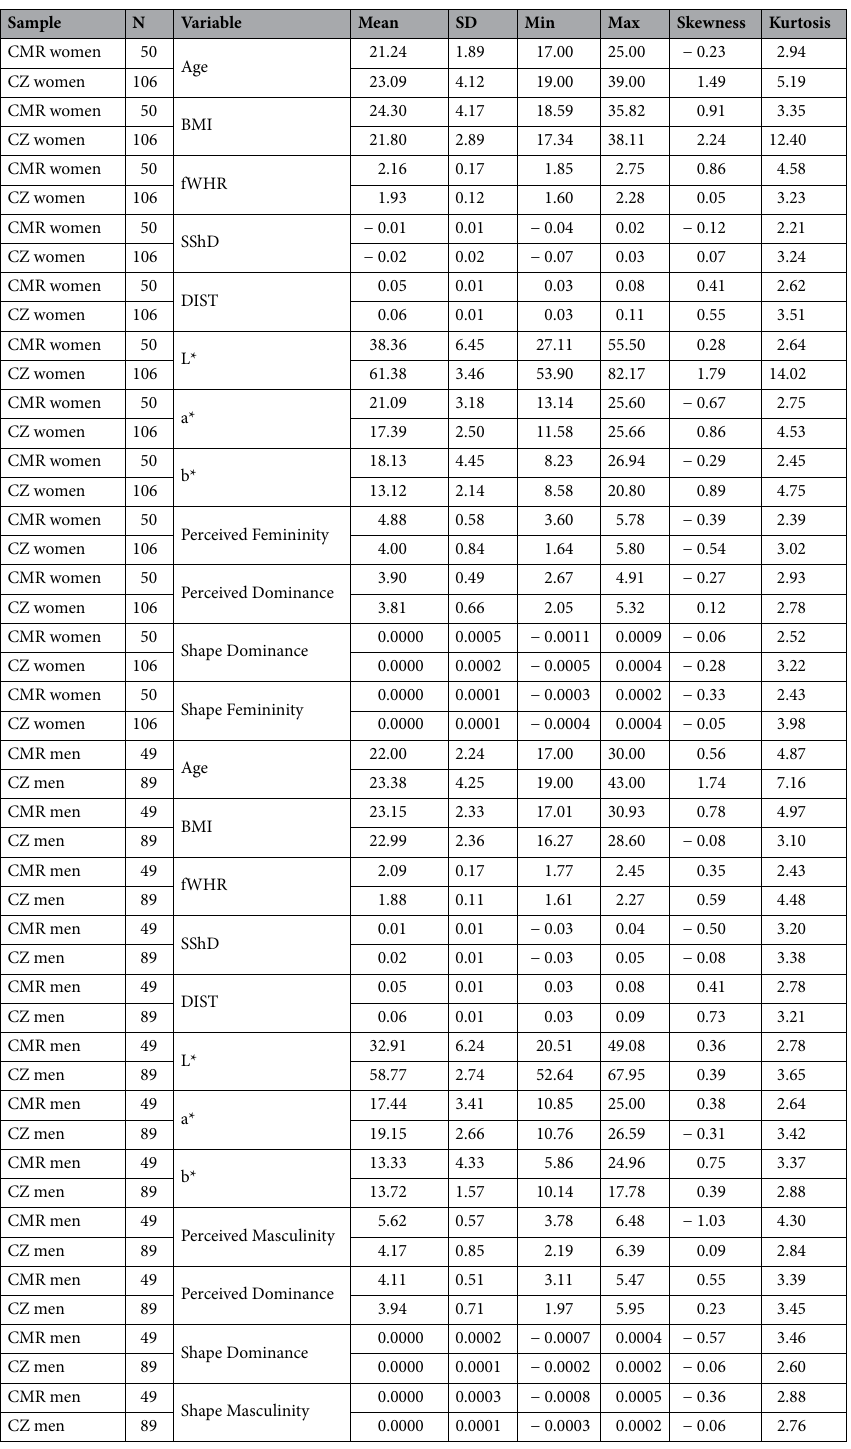
Table 1. The counts of stimuli and their descriptive statistics. BMI body mass index, fWHR facial width-to- height ratio, SShD sexual shape dimorphism, DIST morphological distinctiveness (distance from mean sample configuration), L *, a *, b * lightness, redness, and yellowness dimension (respectively) of CIELab colour space; Shape Dominance and Shape Masculinity/Femininity = shape component (shape variance) of ratings of stimuli dominance and sex-typicality (Masculinity/Femininity), CMR Cameroon, CZ Czech Republic, SD standard